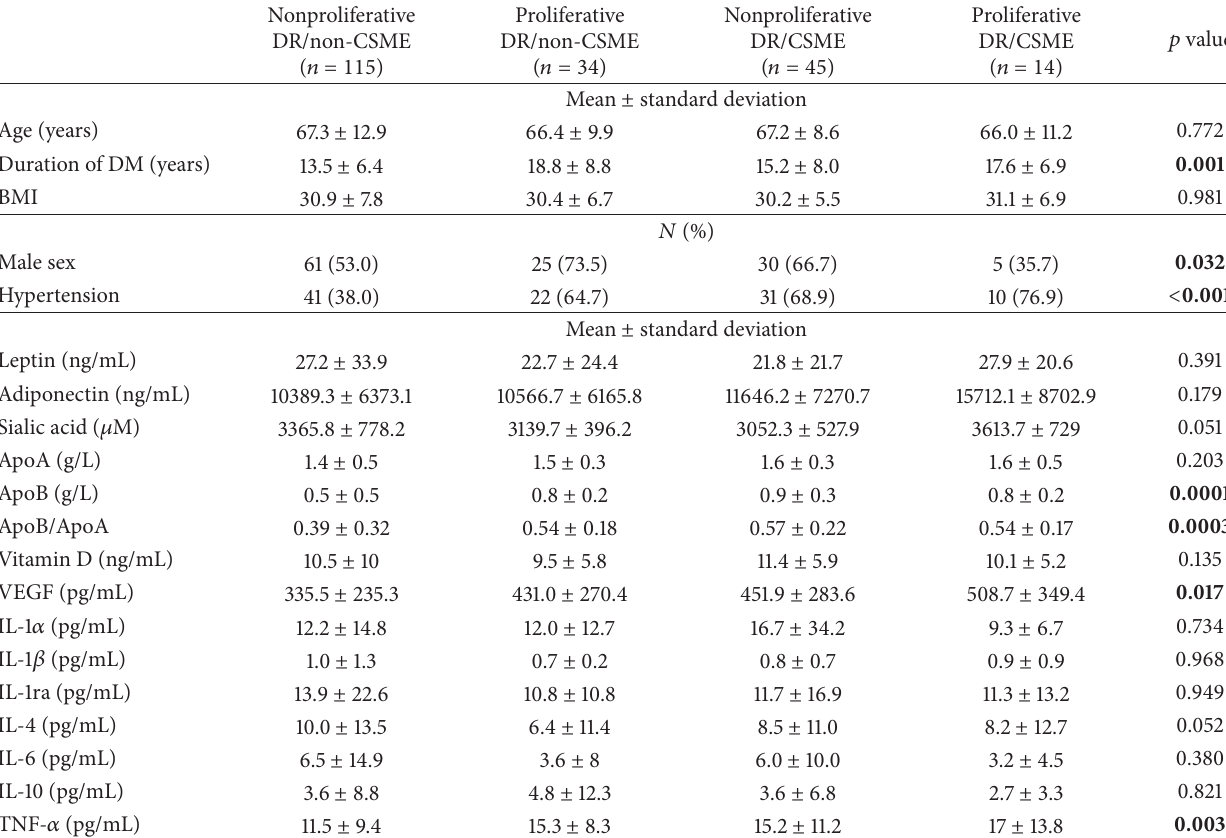
Table 1: Demographic characteristics and inflammatory markers in our sample. Bold cells denote statistically significant